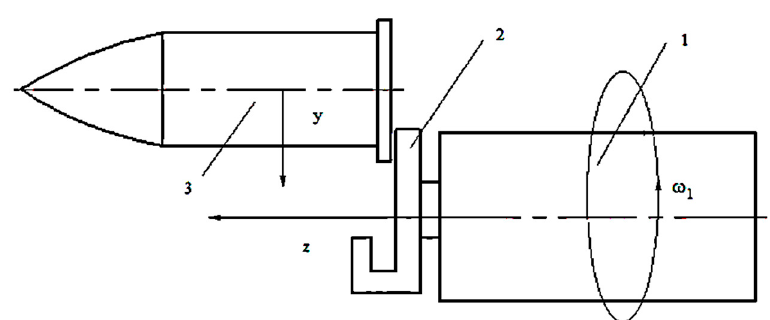
Figure 4. Model of the cam-roller follower mechanism. 1—fixed cylindrical cam, 2—bolt body, and 3—main roller.